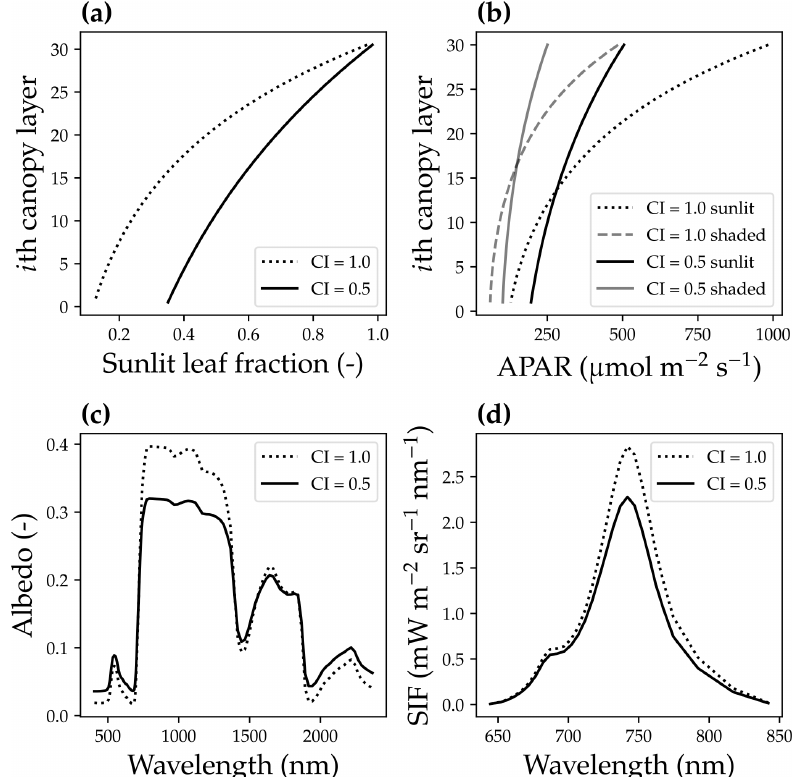
Figure 4. The impact of canopy clumping on canopy radiative transfer. (a) The impact of the canopy clumping index (CI) on the sunlit leaf fraction. (b) CI impacts on the mean sunlit and shaded leaf-absorbed photosynthetic radiation (APAR). (c) CI impacts on the canopy reflectance spectrum. (d) CI impacts on the solar-induced chlorophyll fluorescence spectrum. The model simulation was done using a canopy with a leaf area index of 3, 30 canopy layers, a solar zenith angle of 30 ◦ , a viewing zenith angle of 0 ◦ , and a constant fluorescence yield of